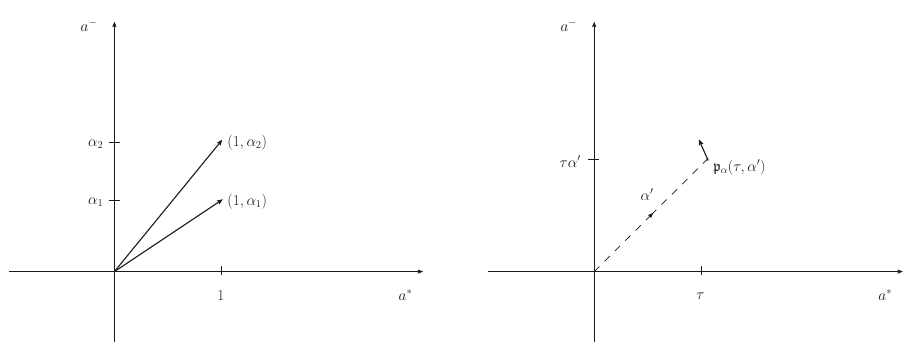
, e α defined in eq. (4.2) in the 2D space. Right: 1 2